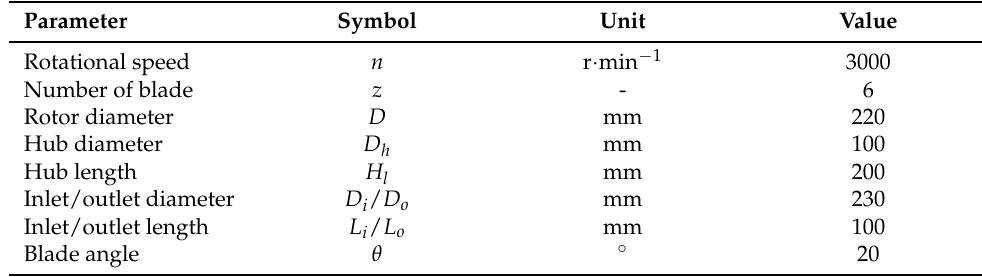
Table 1. Parameters of the axial